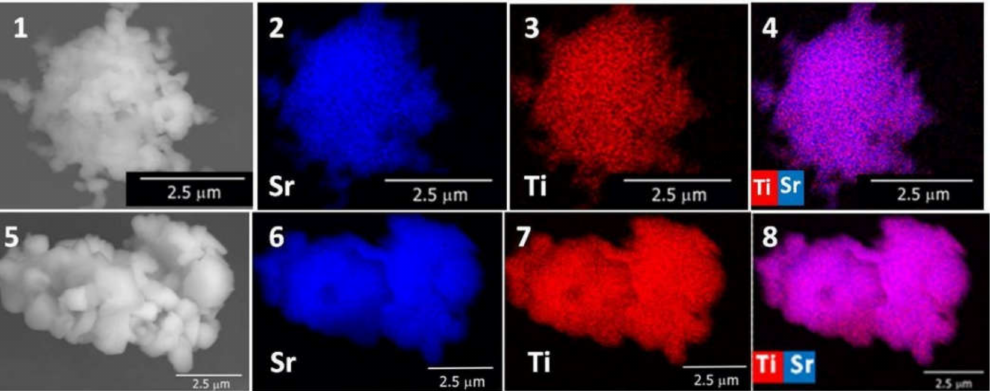
Figure 13. The elemental mapping images of Sr and Ti from the selected area of MA-1 ( 1 – 4 ) and MA-2 ( 5 - 8 ) annealed at 1100 ◦